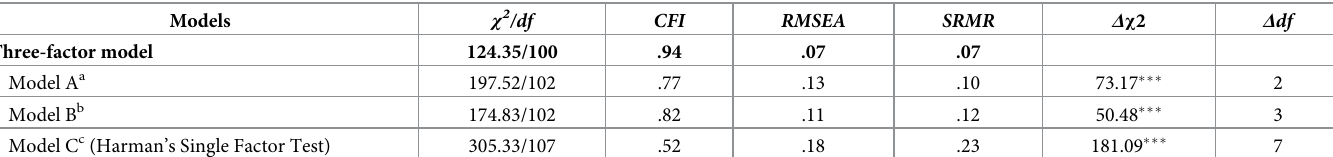
Table 1. Fit statistics from CFA